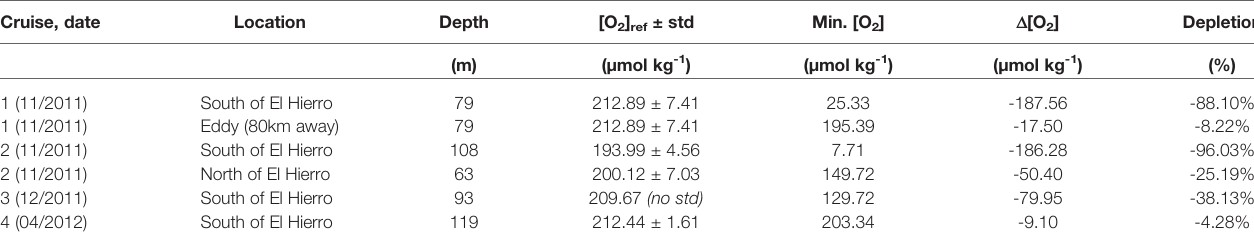
TABLE 2 | Minimum concentrations of dissolved oxygen during the eruptive stage at the depth of maximum